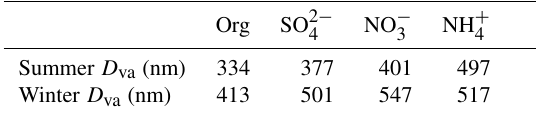
Table 3. Mode diameter of mass distributions of species measured by AMS ( D p corresponds to the vacuum aerodynamic diameter ( D va )) for the summer and winter